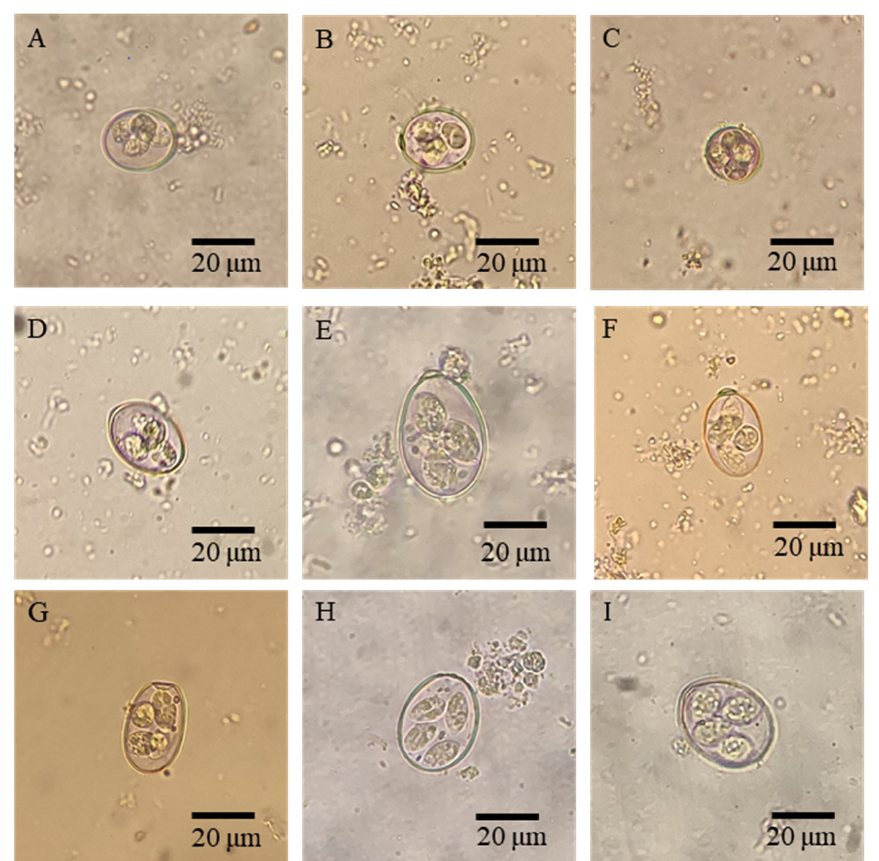
Figure 1. Morphological examination of sporulated oocysts of nine Eimeria species identified in goats in the present study. ( A – I ) Sporulated oocysts of E. ninakohlyakimovae , E. hirci , E. alijevi , E. jolchijevi , E. christenseni , E. arloingi , E. caprina , E. caprovina, and E. apsheronica , respectively.